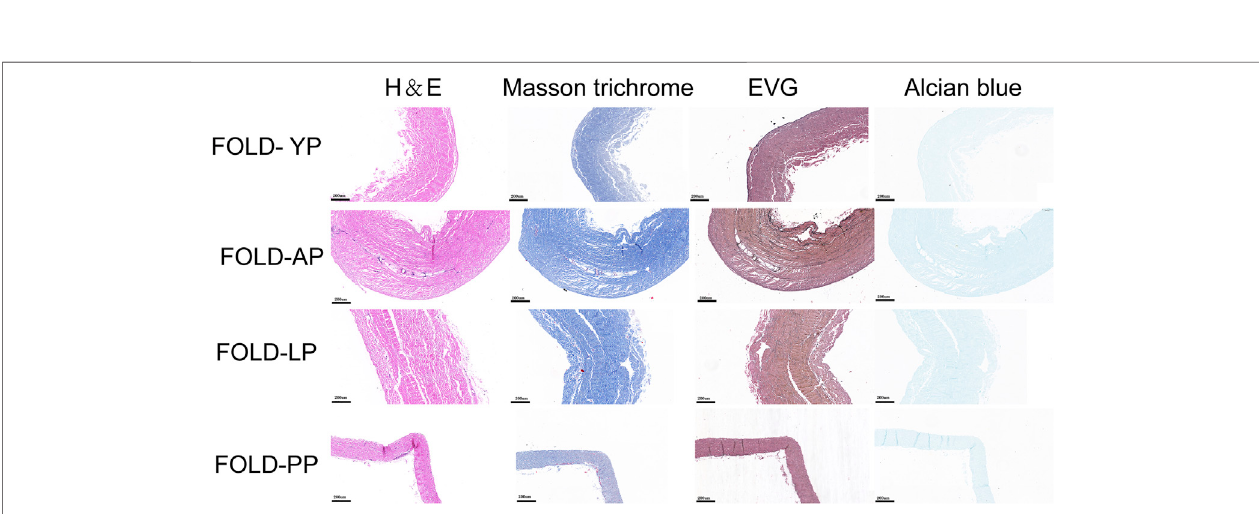
FIGURE9| HEstaining,MASSONstaining,EVGstaining,andAlcianbluestainingforECMevaluationofFold-yakpericardium,Fold-Australianbovinepericardium, Fold-local bovine pericardium, and Fold-porcine pericardium. scale bars are 200 um.